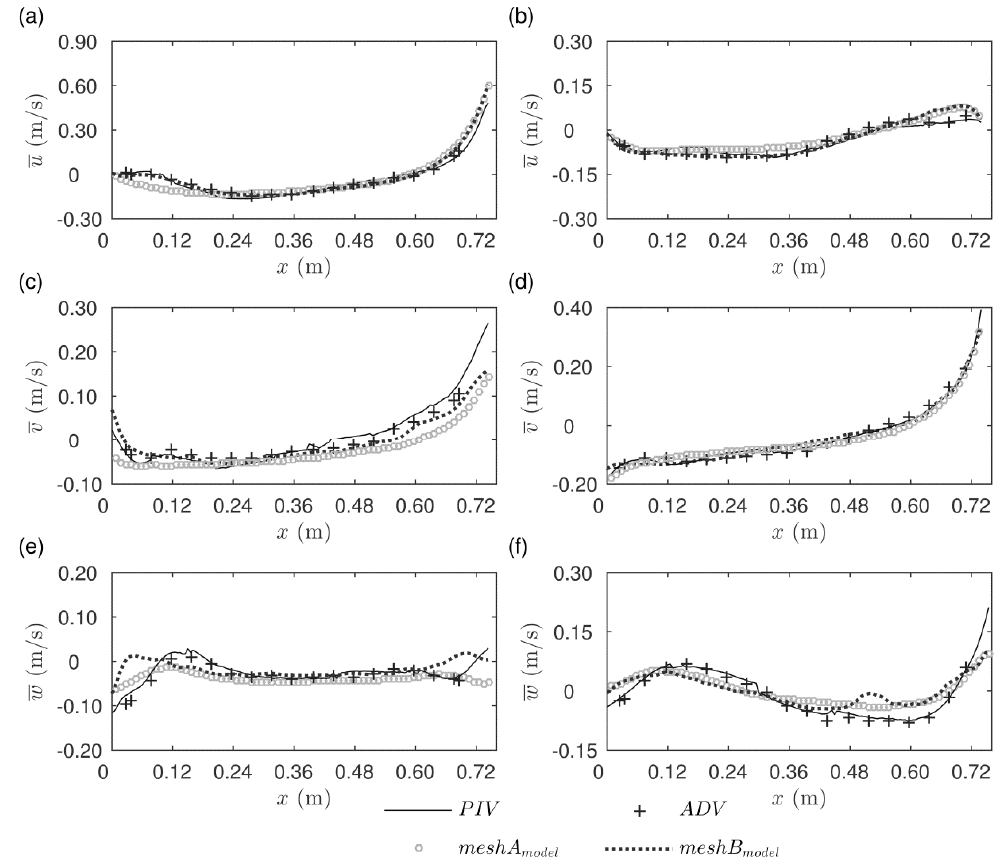
Figure 5. Longitudinal variation of velocity components: ( a , c , e ) planes 1 and 6 intersection ( y = 0.36 m and z = 0.04 m); ( b , d , f ) planes 2 and 5 intersection ( y = 0.20 m and z = 0.088 m).